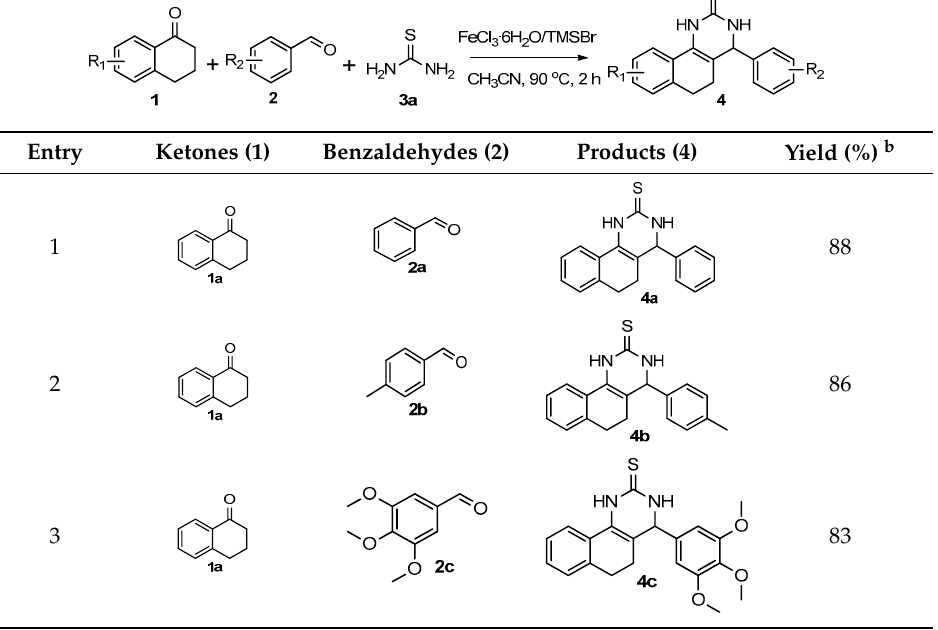
Table 2. FeCl 3 ∙ 6H 2 O/TMSBr catalyzed synthesis of 3,4-dihydropyrimidin-2(1 H )-thiones a .